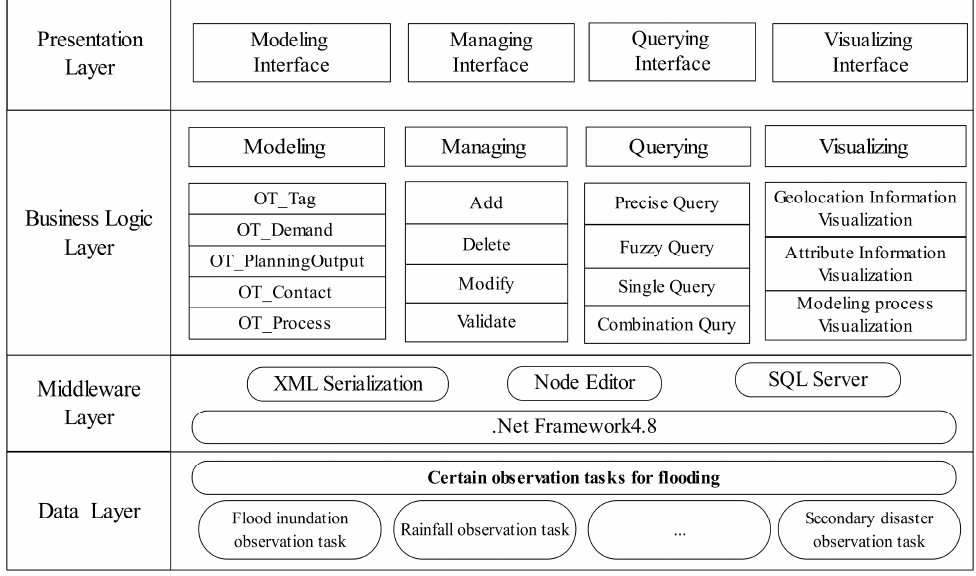
Figure 6. Prototype of system architecture.